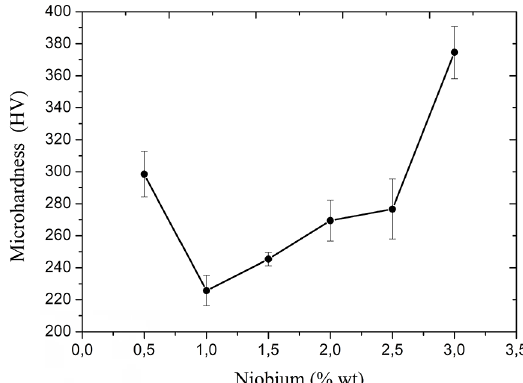
Figure 7. Microhardness (HV) behavior of the Cu-Al-Nb HTSMA as a function of Nb